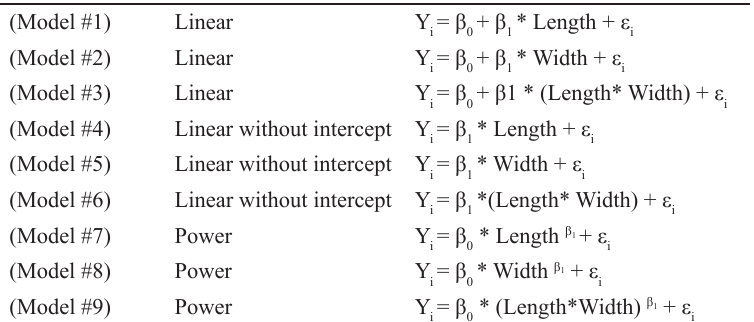
Table 2. Statistical models and equations to predict leaf area as a function of linear dimensions of leaves (Model